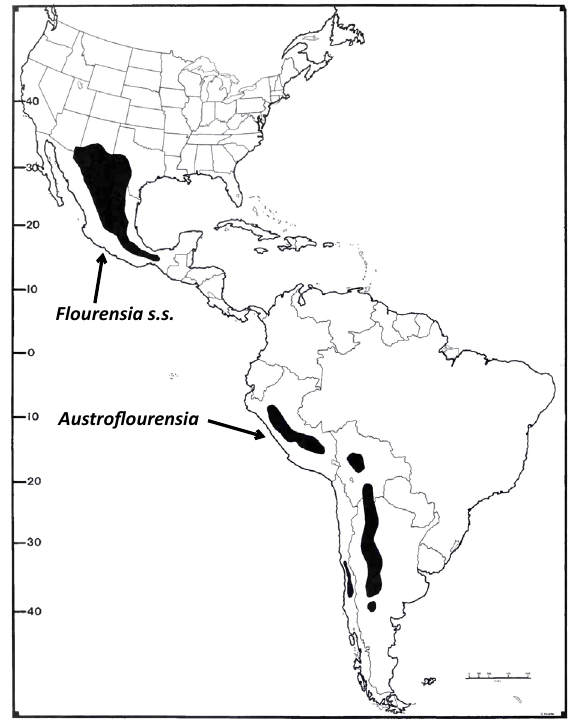
Figure 3. Distribution of Flourensia and Austroflourensia (modified from Dillon